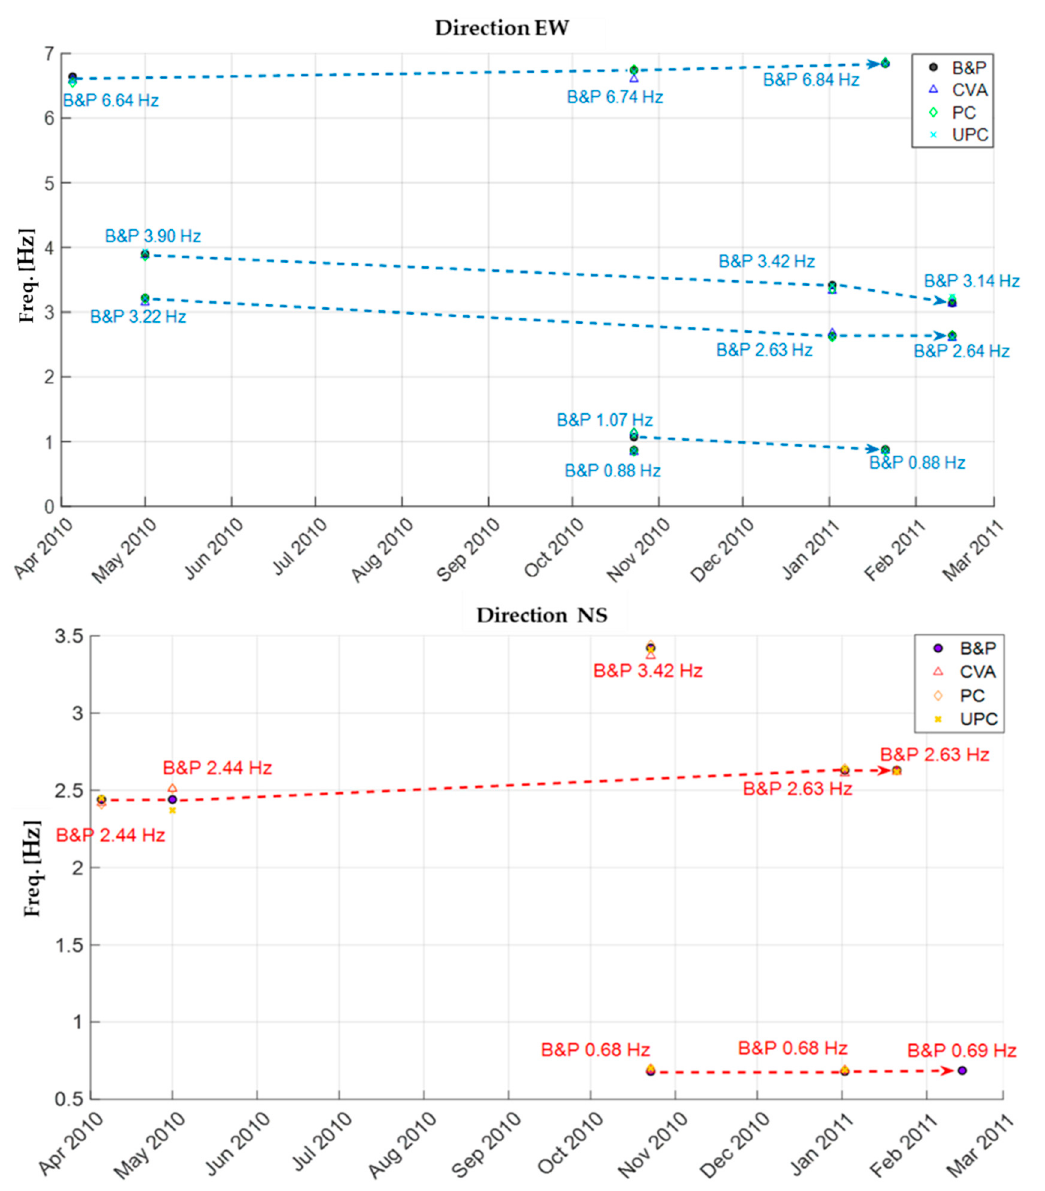
Figure 10. Identified frequencies by date for the east-west and north-south directions showing how the frequency varies during the time the building was instrumented. the frequency varies during the time the building was